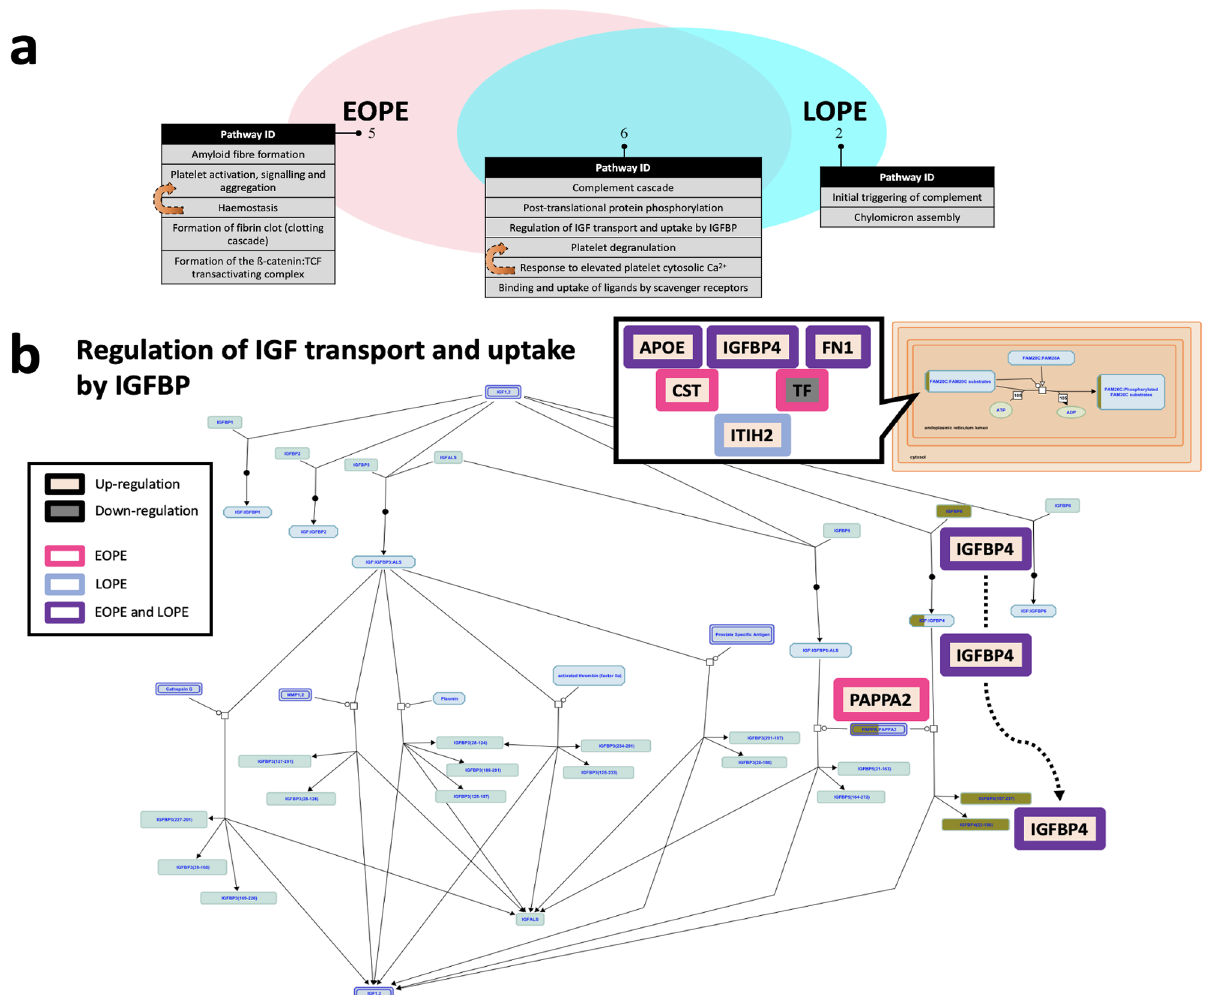
Figure 3. Pathway analysis. ( a ) Triple Venn diagram illustrating the number of pathways significantly changed in EOPE versus healthy pregnancy and LOPE versus healthy pregnancy. ( b ) Illustrative example of DE protein perturbations in the regulation of IGF transport and uptake through IGFBP. IGF insulin-like growth factor, IGFBP insulin-like growth factor binding protein. Source data are provided as a Source Data